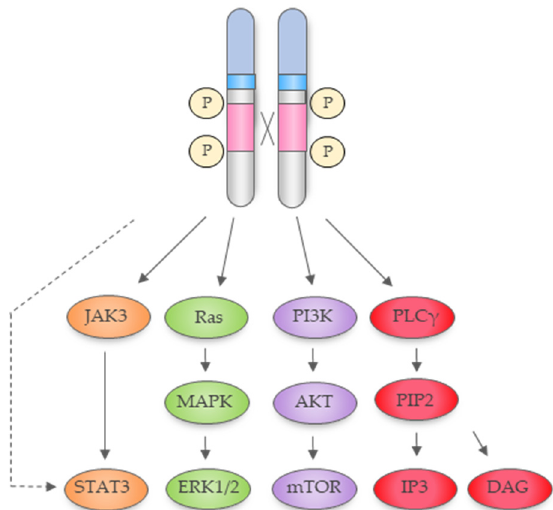
Figure 2. The NPM1-ALK fusion protein signals through the Janus protein tyrosine kinase (JAK)/STAT, Ras/mitogen-activated protein kinases (MAPK), phosphatidylinositol 3-kinase (PI3K)/AKT and phospholipase C gamma (PLC- γ ) pathways. Adapted from Trigg et al., 2018 [39].